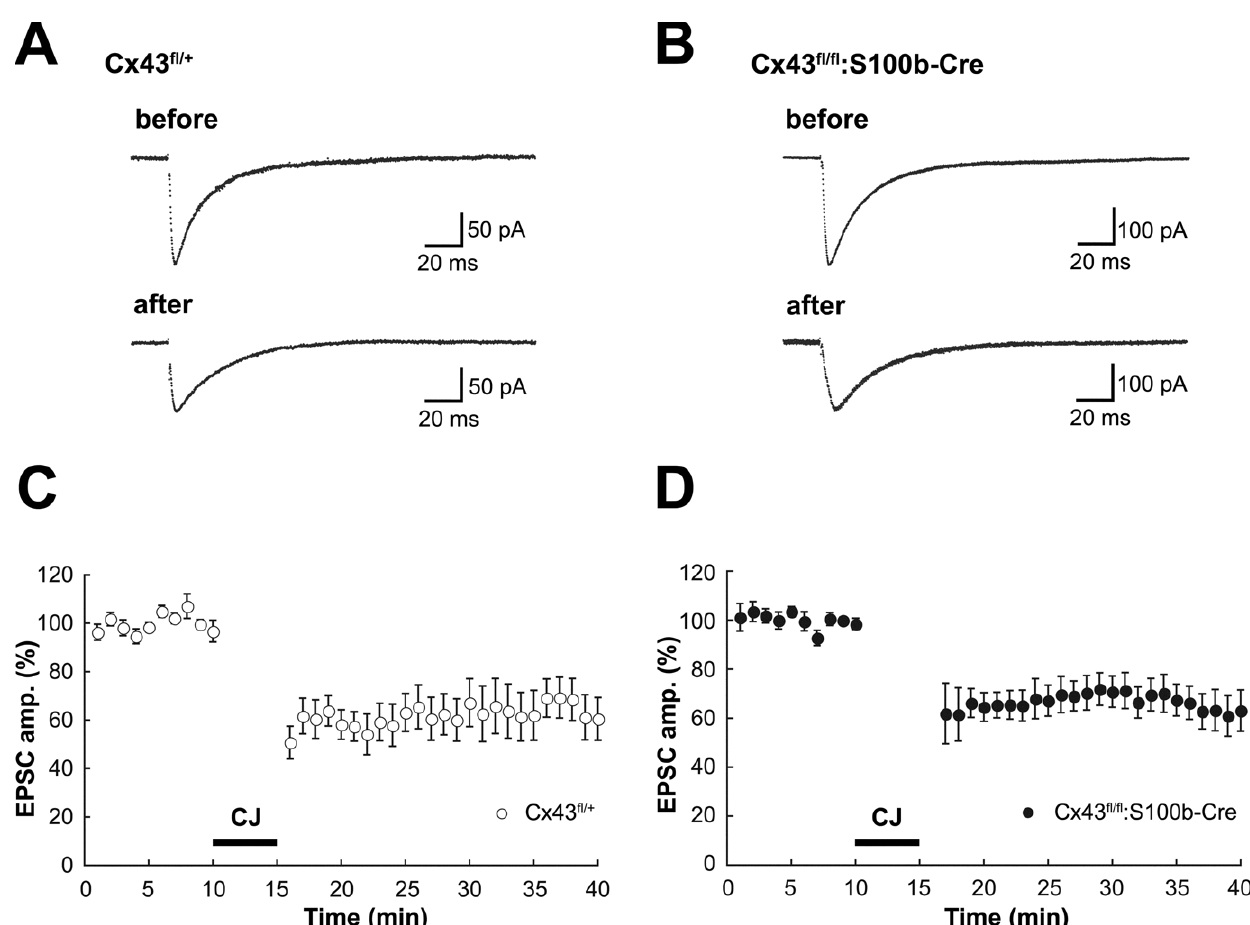
Figure 9. Basal PF-PC EPSC and LTD induction in control ( Cx43 fl / + ) and Cx43 fl /fl :S100b-Cre mice. (A, B) A representative example of PF-EPSC before and after conjunctive stimulation in Cx43 fl / + (A) and Cx43 fl /fl :S100b-Cre (B) mice. Six records are averaged. (C, D) PF-EPSC amplitude was plotted against time before and after conjunctive stimulation averaged for 8 cells from 8 Cx43 fl / + mice (C) or for 9 cells from 8 Cx43 fl /fl :S100b-Cre mice (D) . Each point